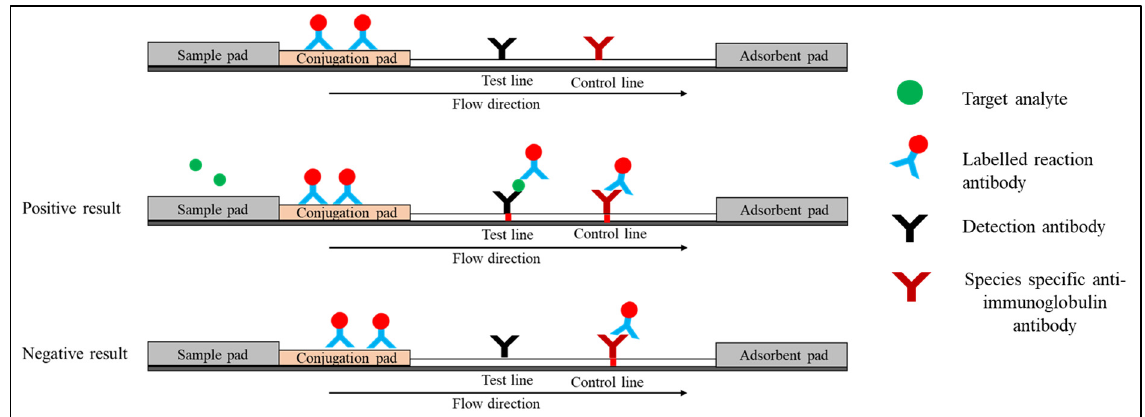
Figure 2. Schematic diagram shows the sandwich format of LFI.